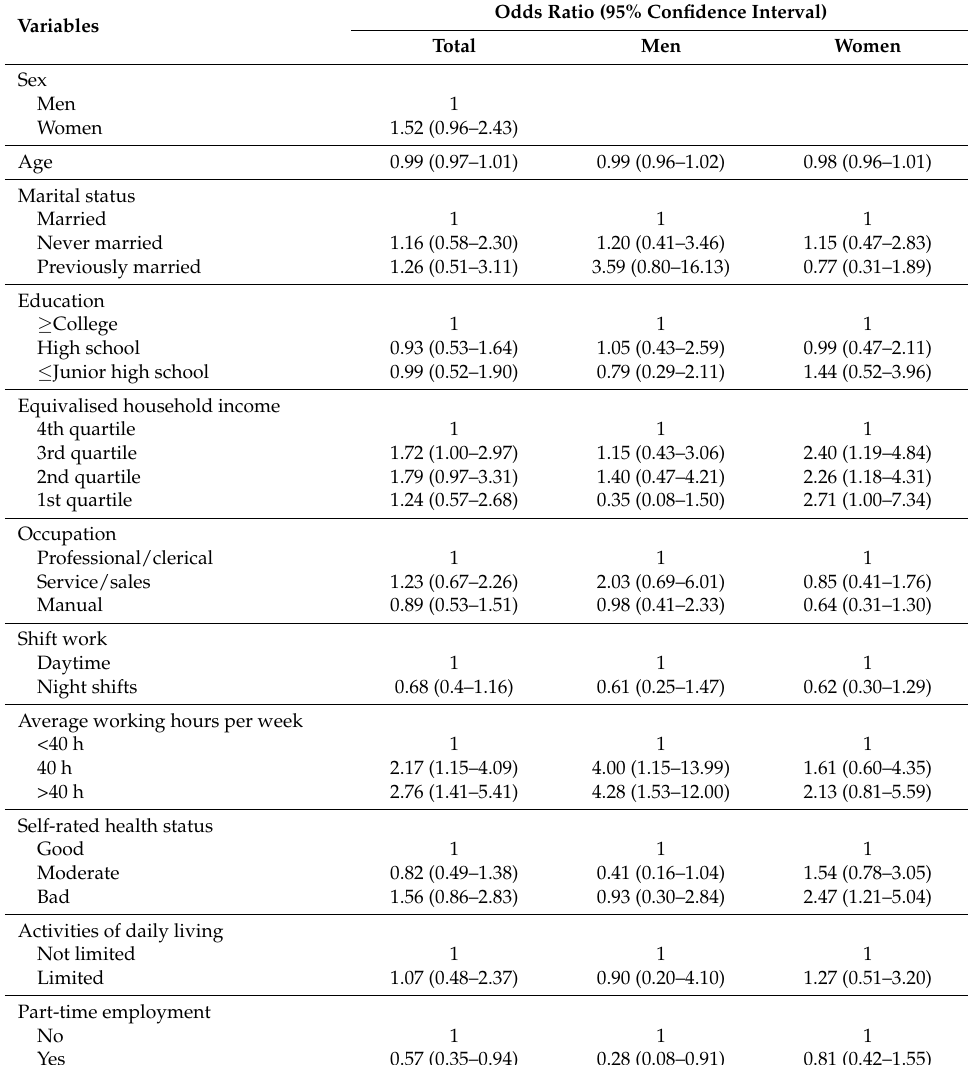
Table A2. Factors associated with self-reported unmet healthcare needs after adding part-time employment by sex among precarious